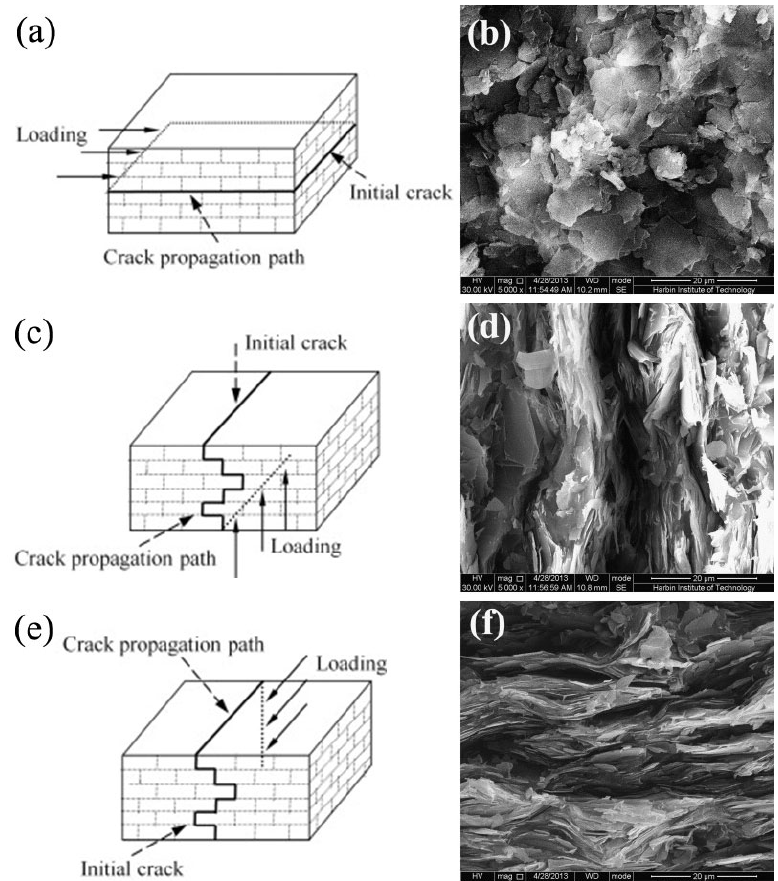
Fig. 31 Fracture mechanisms and fracture morphologies of textured h-BN-mullite composites with lamellar structure under different loading situations: (a, b) D1; (c, d) D2; (e, f) D3. Reproduced with permission from Ref. [4], © Elsevier B.V. 2014.